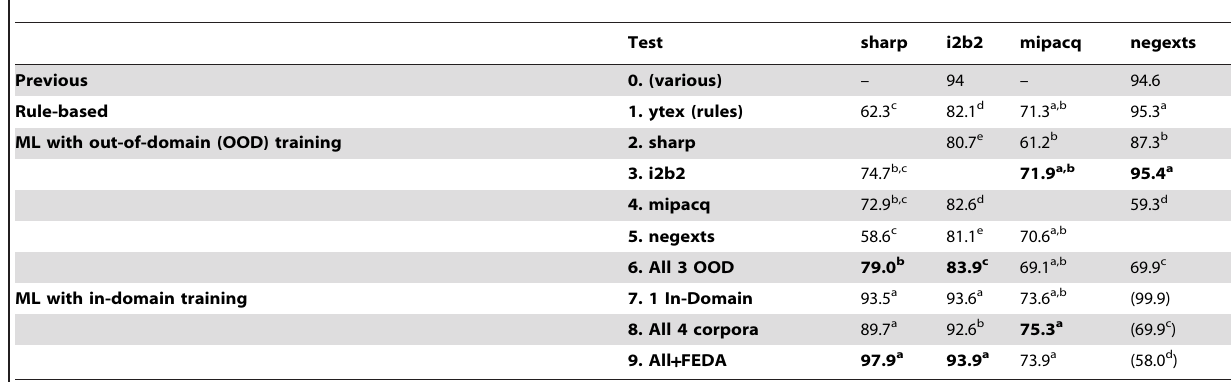
Table 4. Performance (F 1 score) in practical negation detection